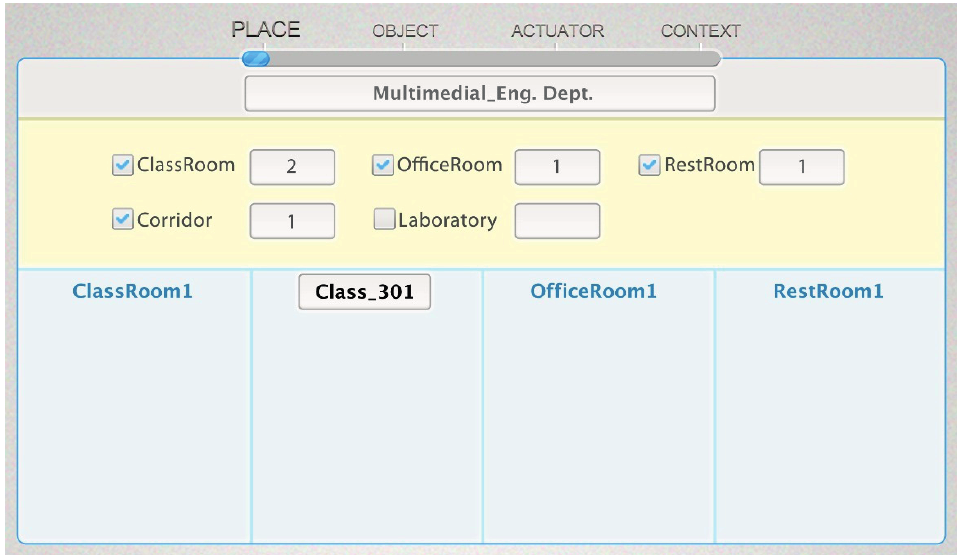
Figure 12. Web-based service modeling UI (Phase 1: place setting).